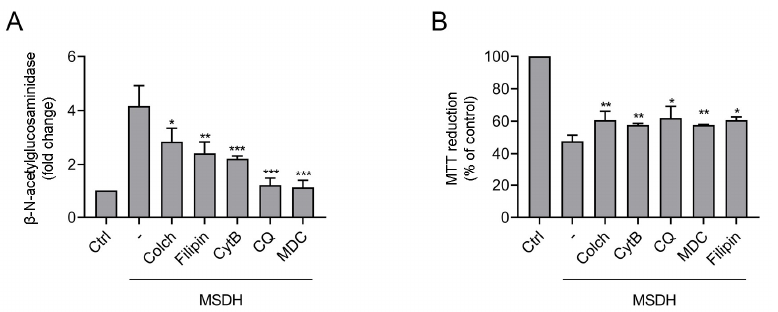
Figure 7. Effect of endocytosis inhibitors on MSDH toxicity. Endocytosis was prevented by pretreatment with chloroquine (CQ, 10 μM, 30 min), colchincine (Colch, 10 μM, 1 h), cytochalasin B (Cyt B, 5 μM, 1 h), mono-dansylcadaverine (MDC, 50 μM, 30 min) or filipin (0.5 μM, 30 min). ( A ) β- N-acetyl-glucoseaminidase (NAG) activity in cytosolic fractions after 30 min of MSDH exposure (15 μM). ( B ) Viability after 1 h of MSDH exposure (15 μM). Each inhibitor is compared with its respective control. Results are shown as mean ± SD, ( n = 3), * p < 0.05, ** p < 0.01 and *** p < 0.001 compared to sample exposed to MSDH